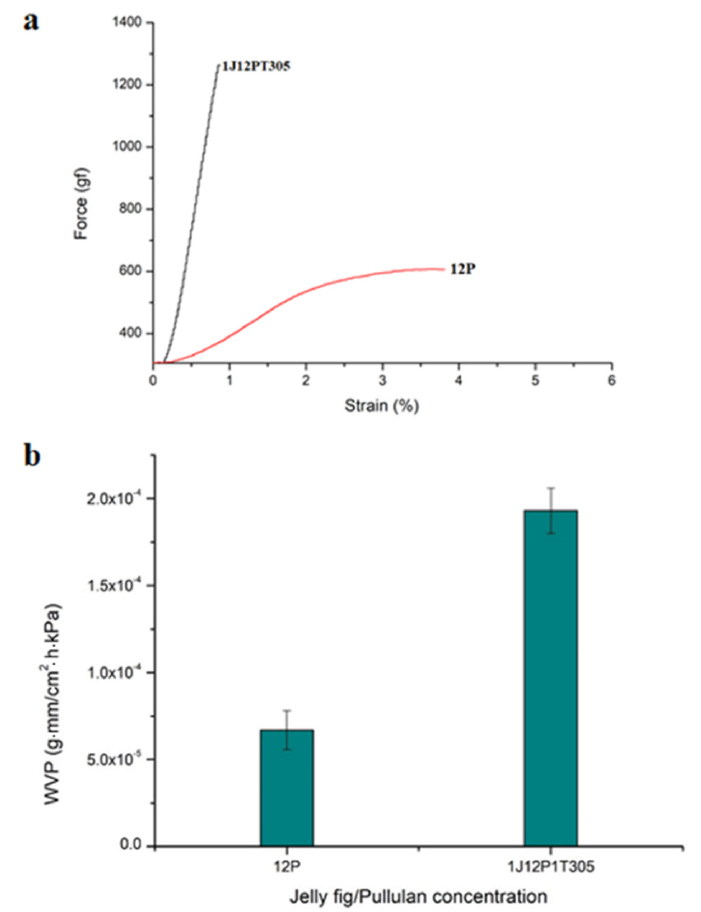
Figure 7. ( a ) The tensile strength of pullulan and JFP/pullulan nanofibers; ( b ) water vapor perme- ability coefficients of pullulan and JFP/pullulan nanofibers at 25 ◦ C with 75% relative humidity